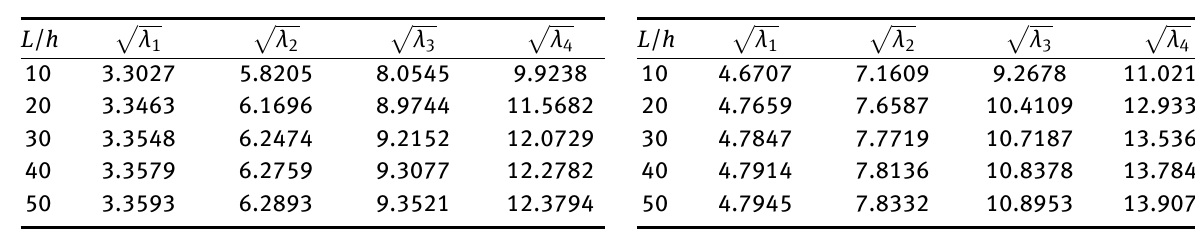
(︁ √ )︁ for CS case for different λ